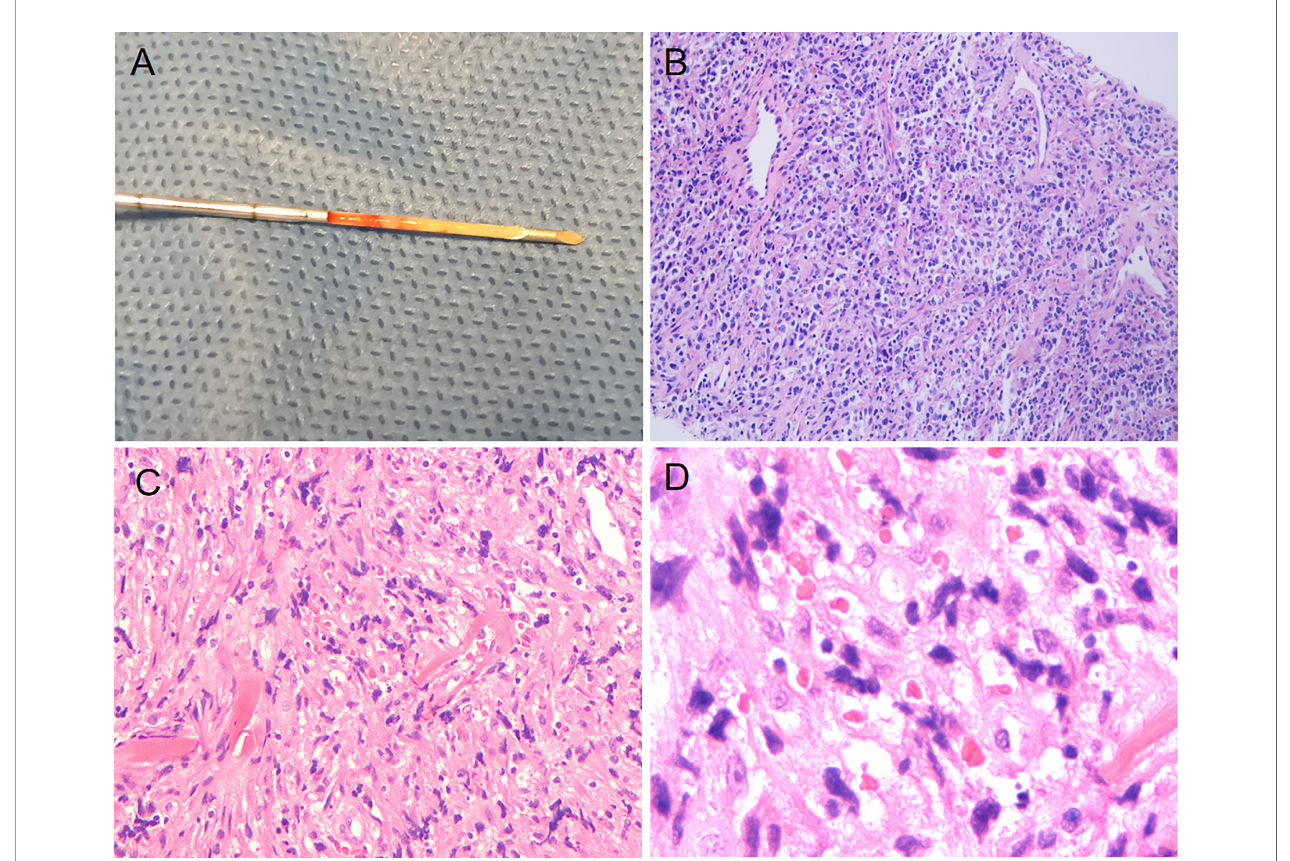
FIGURE 4 | Puncture specimen obtained through ultrasound-guided puncture and histopathologic images showing cells with pleomorphism. (A) Puncture specimen of the right cervical lymph node (obtained from the Hangzhou Red Cross Hospital). (B) Pathological images taken with an optical microscope at 400× magni fi cation (right cervical lymph node, obtained from the Department of Pathology at Hangzhou Red Cross Hospital). (C) Pathological images taken with an optical microscope at 10× magni fi cation (left cervical lymph node, obtained from the Department of Pathology at Zhejiang Cancer Hospital). (D) Pathological images taken at 40× magni fi cation under an optical microscope (left cervical lymph node, obtained from the Department of Pathology at Zhejiang Cancer